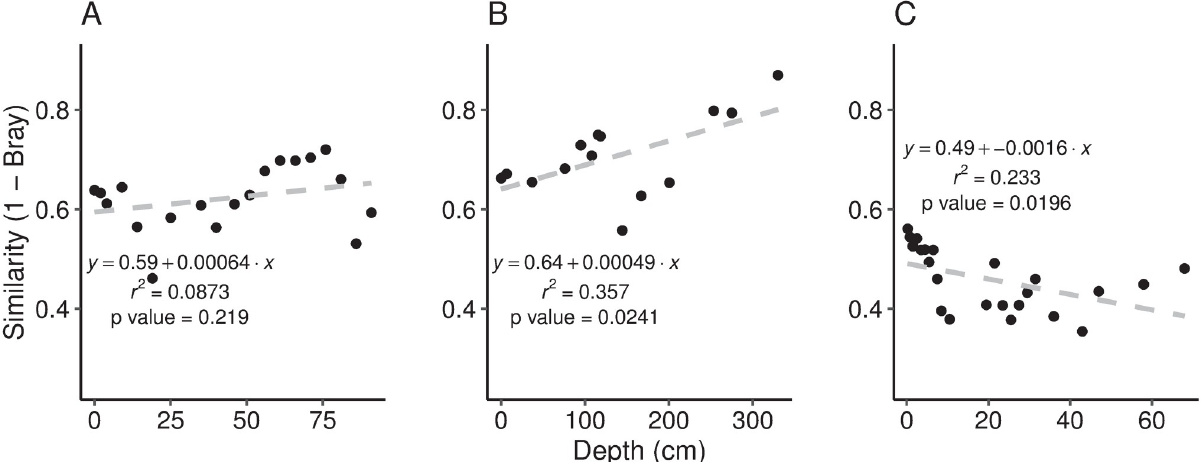
Fig 4. Linear regression of similarity (1-Bray Curtis) and depth slice in Lake Nganoke (A), Lake Paringa (B), and Lake Pounui (C). Depth slices are organised by depth (1 being the most recent). Approximate ages of depth slices vary between lakes and are given in S1 Table.